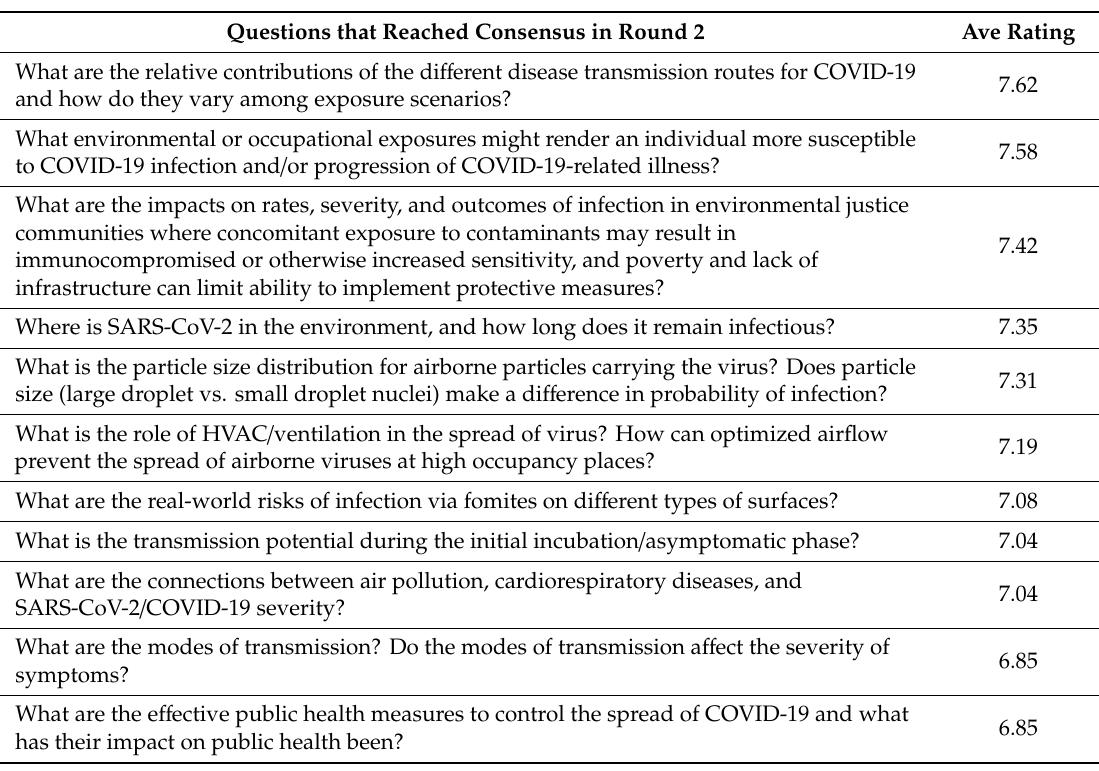
Table 2. Environmental health sciences (EHS) COVID-19 research questions that met consensus threshold as “High